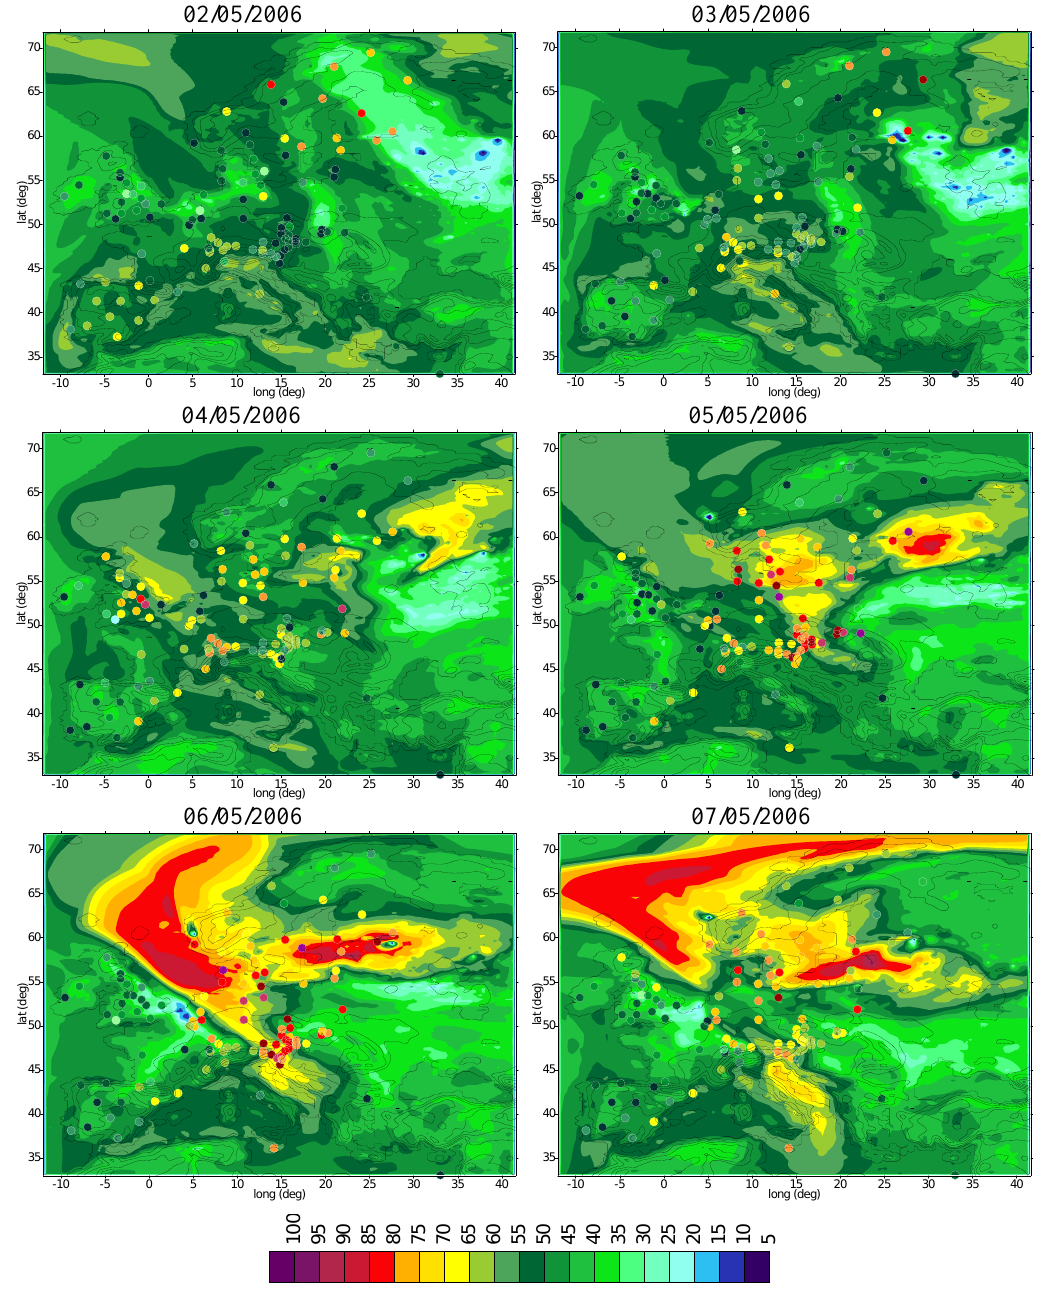
Fig. 7. Predicted (color shade) and observed (symbols) daily maximum hourly O 3 concentrations (ppb) during 2–7 May 2006 for the reference